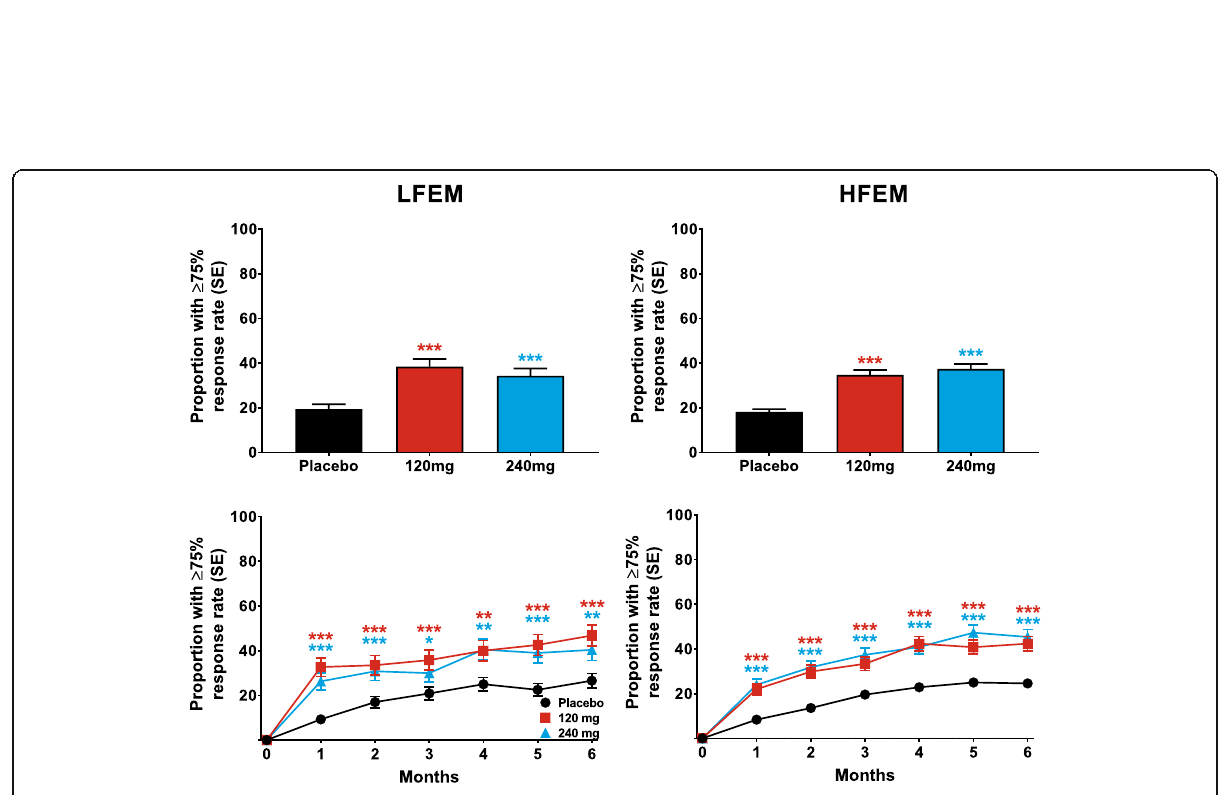
Fig. 3 The overall mean percentage of patients with ≥ 75% reduction from baseline in monthly MHDs across Months1 – 6 is shown for patients with LFEM and HFEM receiving placebo, 120-mg, or 240-mg of galcanezumab in the upper row. The monthly percentage of patients with ≥ 75% reduction in MHDs is shown in the bottom row for patients with LFEM and with HFEM. ***p ≤ .001, **p ≤ .01, *p ≤ .05 vs